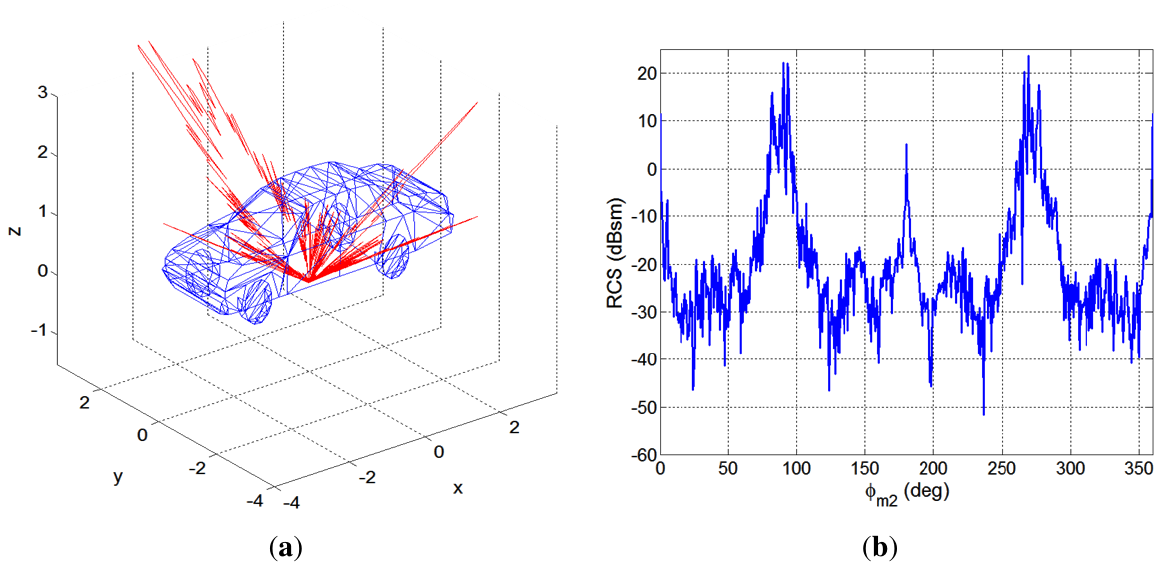
Figure 9. Results obtained for the Monostatic 2 case using POFACETS: ( a ) 3D model of the target and 3D monostatic RCS; ( b ) Monostatic RCS in Cartesian